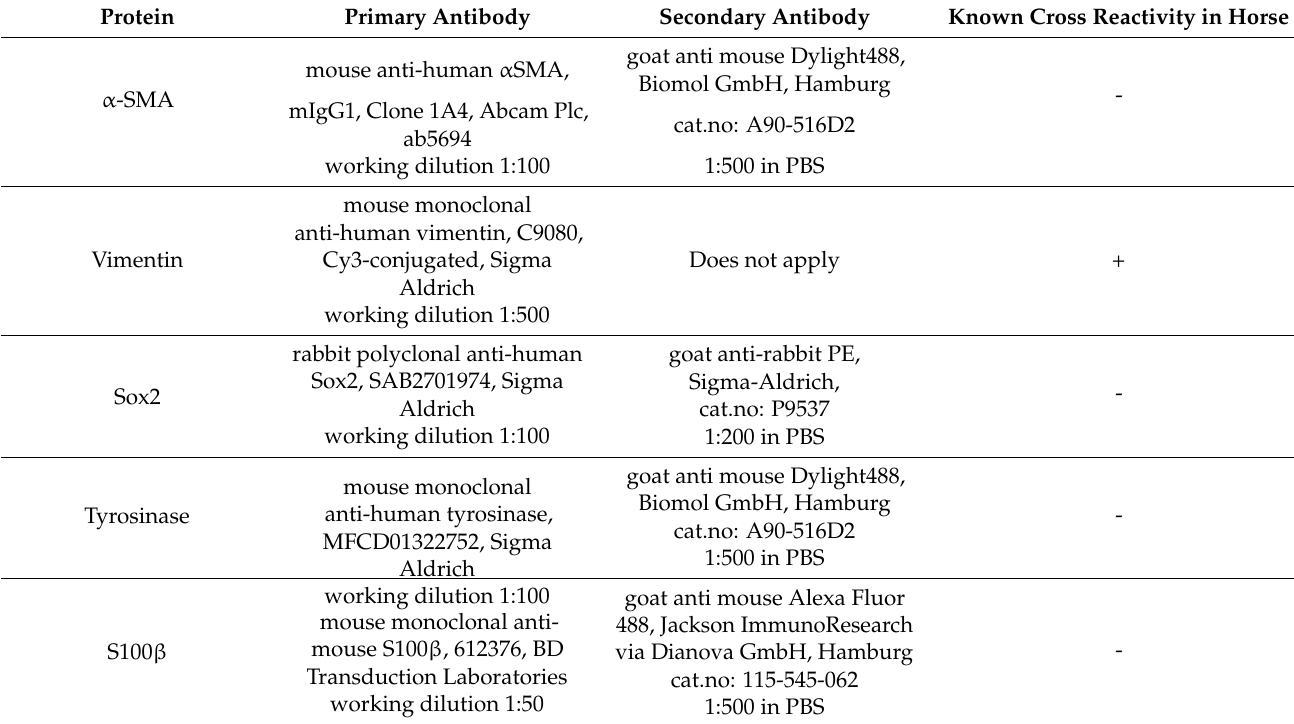
Table 2. List of antibodies used to detect α -SMA, vimentin, Sox2, tyrosinase and S100 β in horse